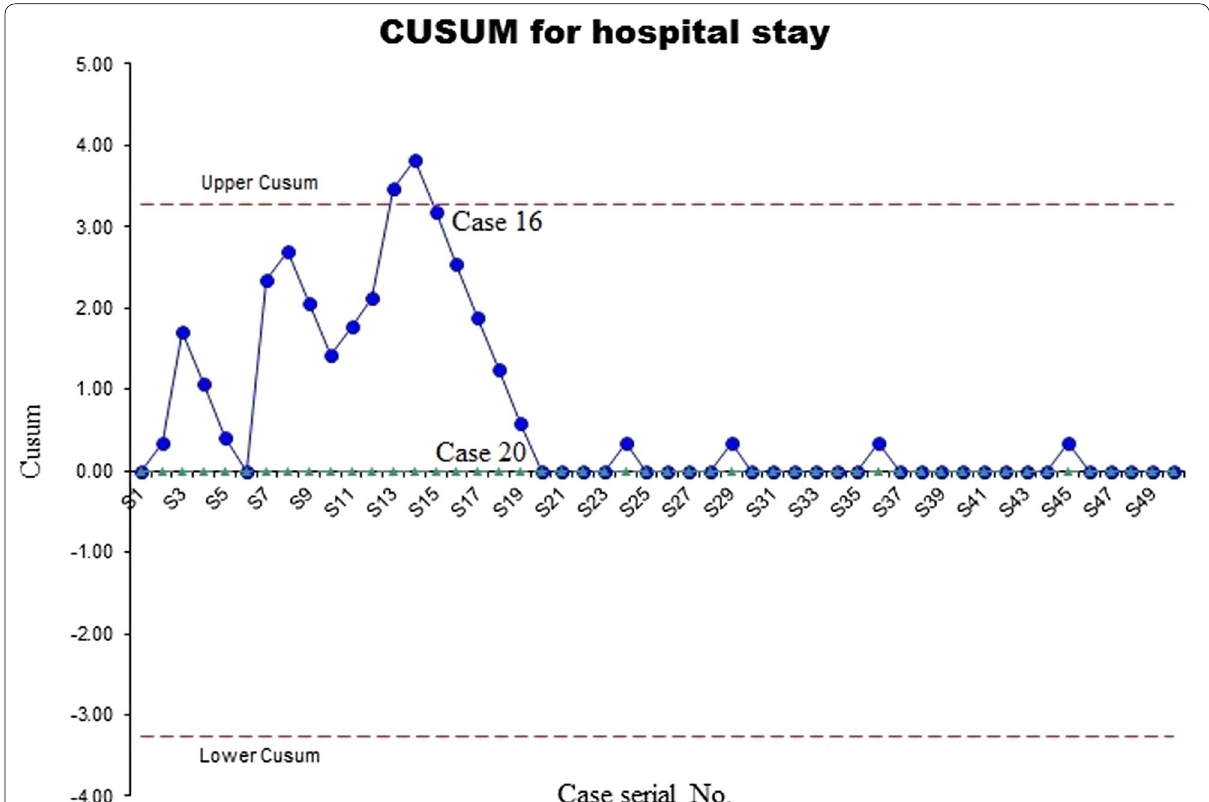
from case 16 onwards